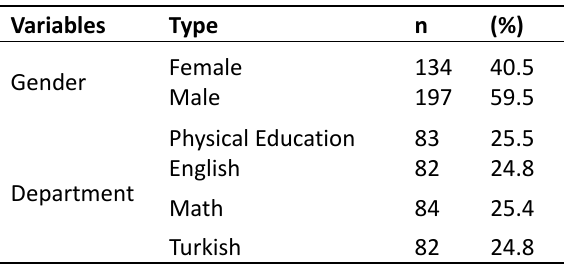
Table 1. Demographics of pre-service teachers